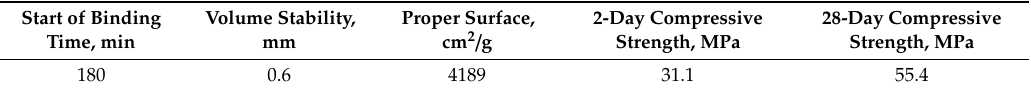
Table 3. Physical and mechanical properties of cement CEM I 42.5 R [34].